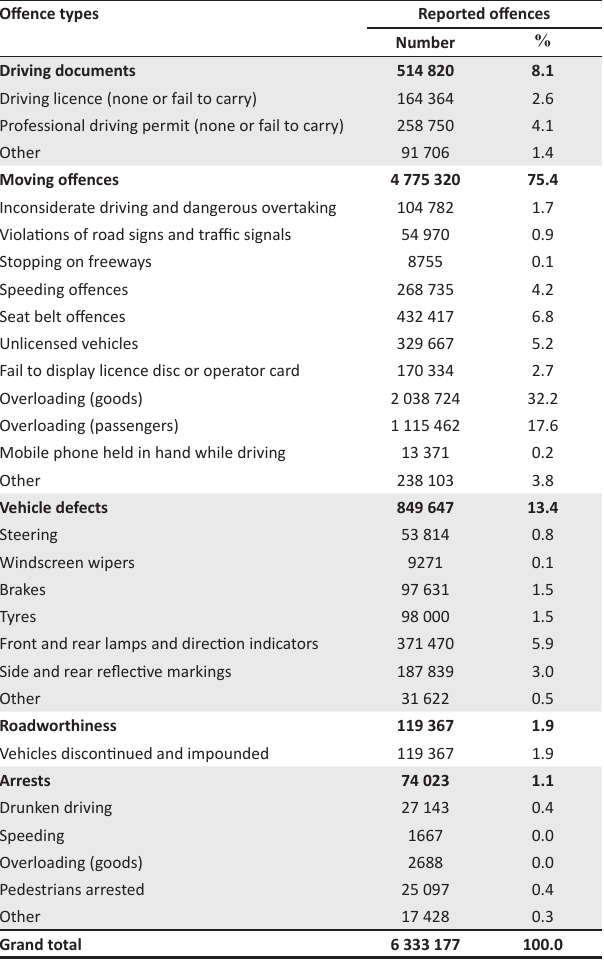
TABLE 2: Reported traffic offences in South Africa (February 2015 to September 2016). Offence types Reported